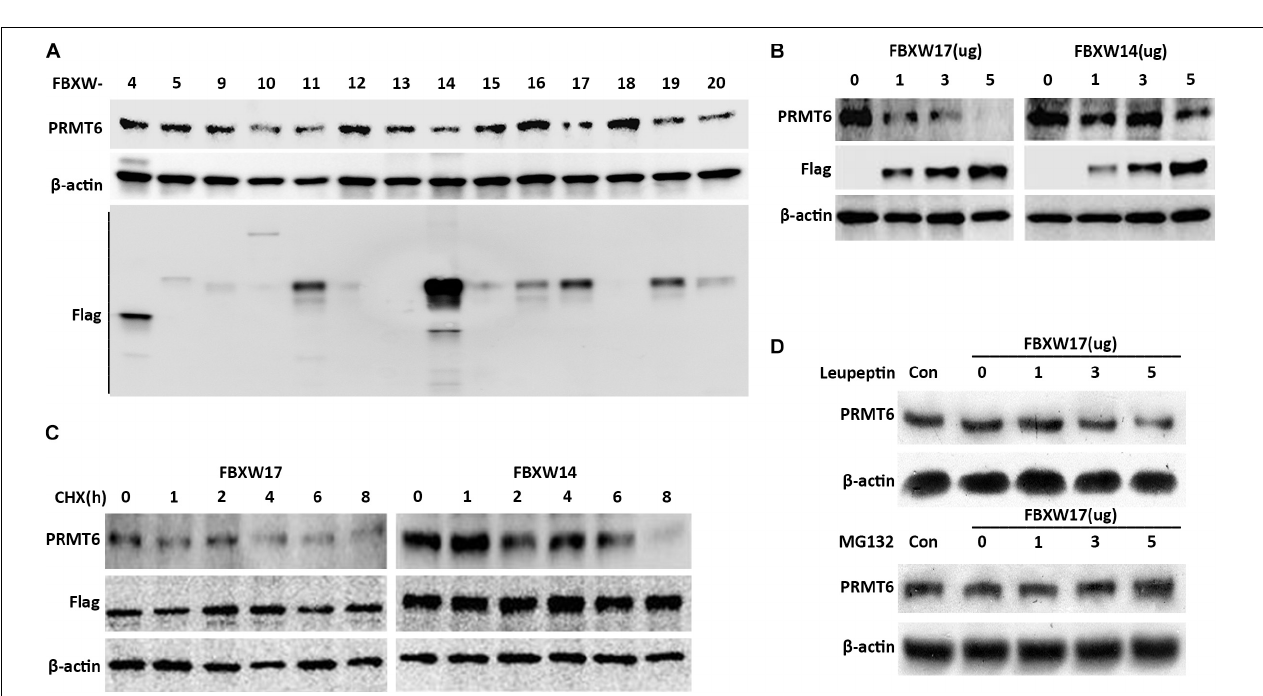
FIGURE 2 | Protein arginine N-methyltransferase 6 (PRMT6) is degraded by proteasome system. (A) MLE12 cells were, respectively, treated with 100 µ g/ml cycloheximide (CHX), 20 µ M MG132, or 100 µ M leupeptin at time points of 1, 2, 4, 6, and 8 h as indicated. Cell lysate was subjected to PRMT6 and β -actin immunoblotting analysis. (B) The densitometric changes of PRMT6 protein expression were plotted. Results are shown with a representative of n = 3 experiments.